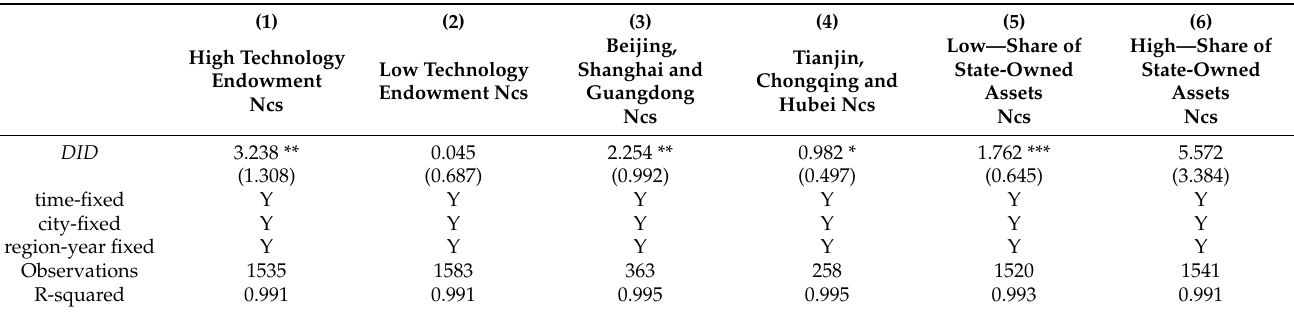
Table 9. Heterogeneity